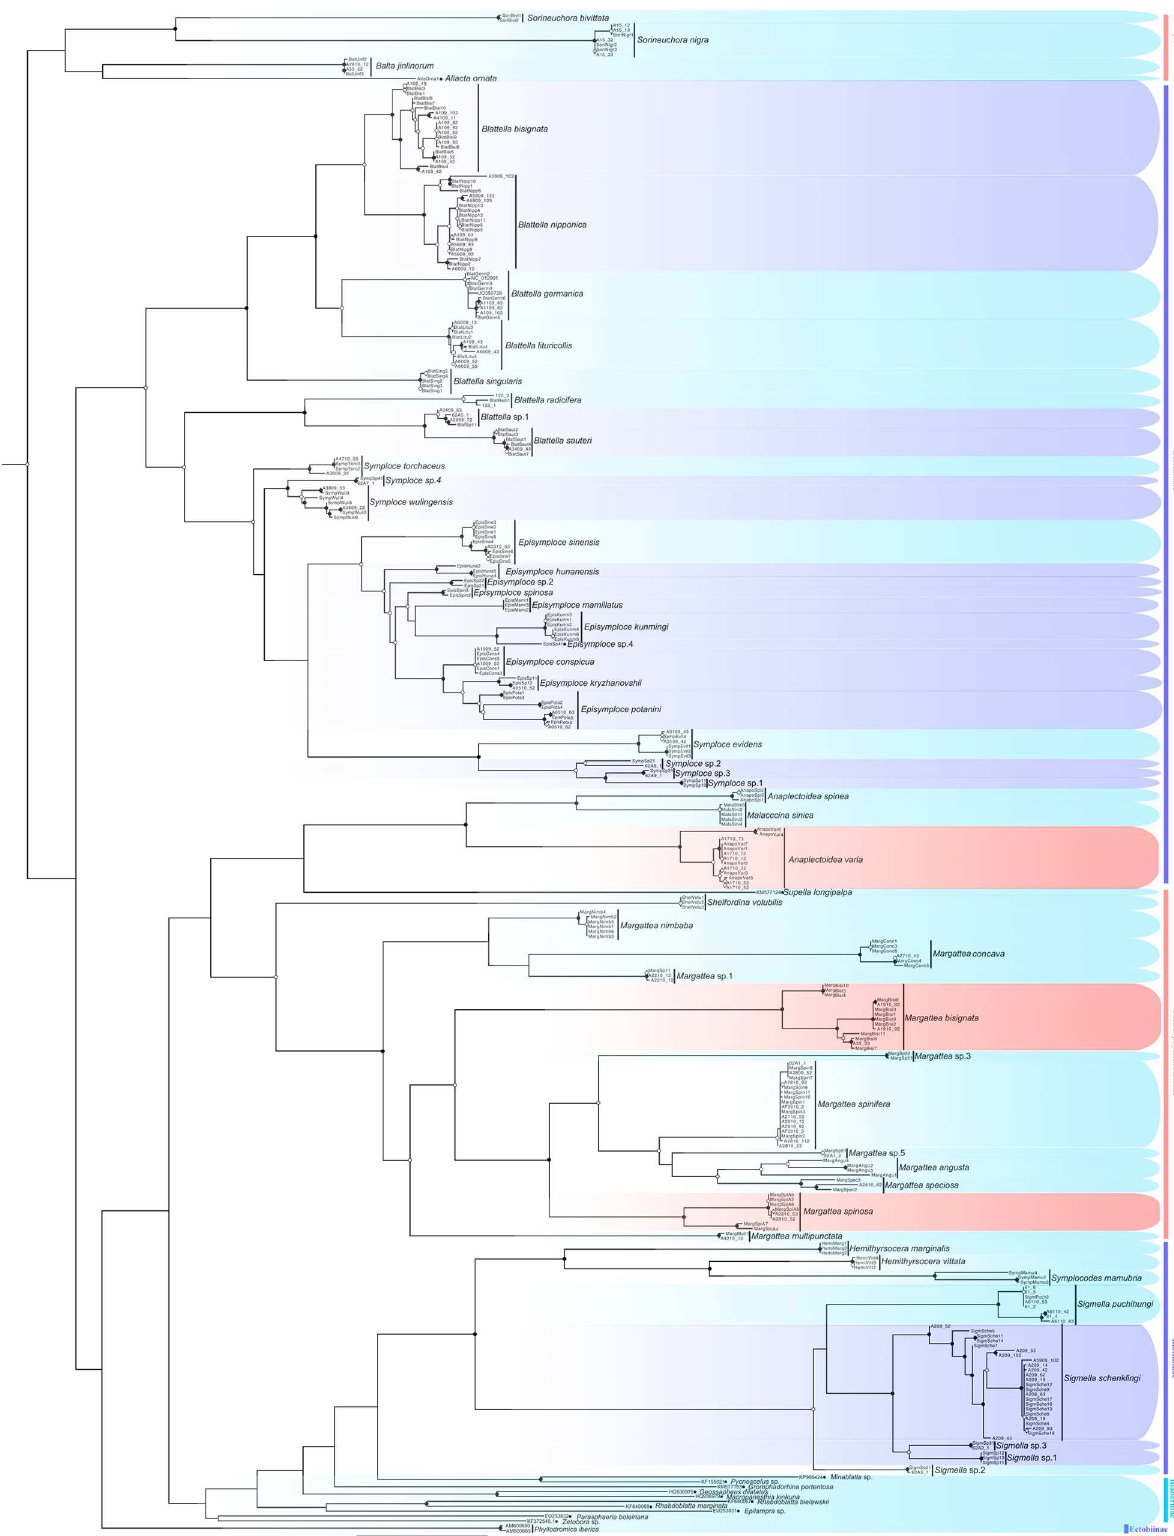
Fig 2. Maximum likelihood (ML) tree derived from COI gene. ● near nodes indicating both BPP and MLB > 90, ■ representing only BPP > 90 and (cid:14) representing only MLB > 90. Outgroupswere not shown.